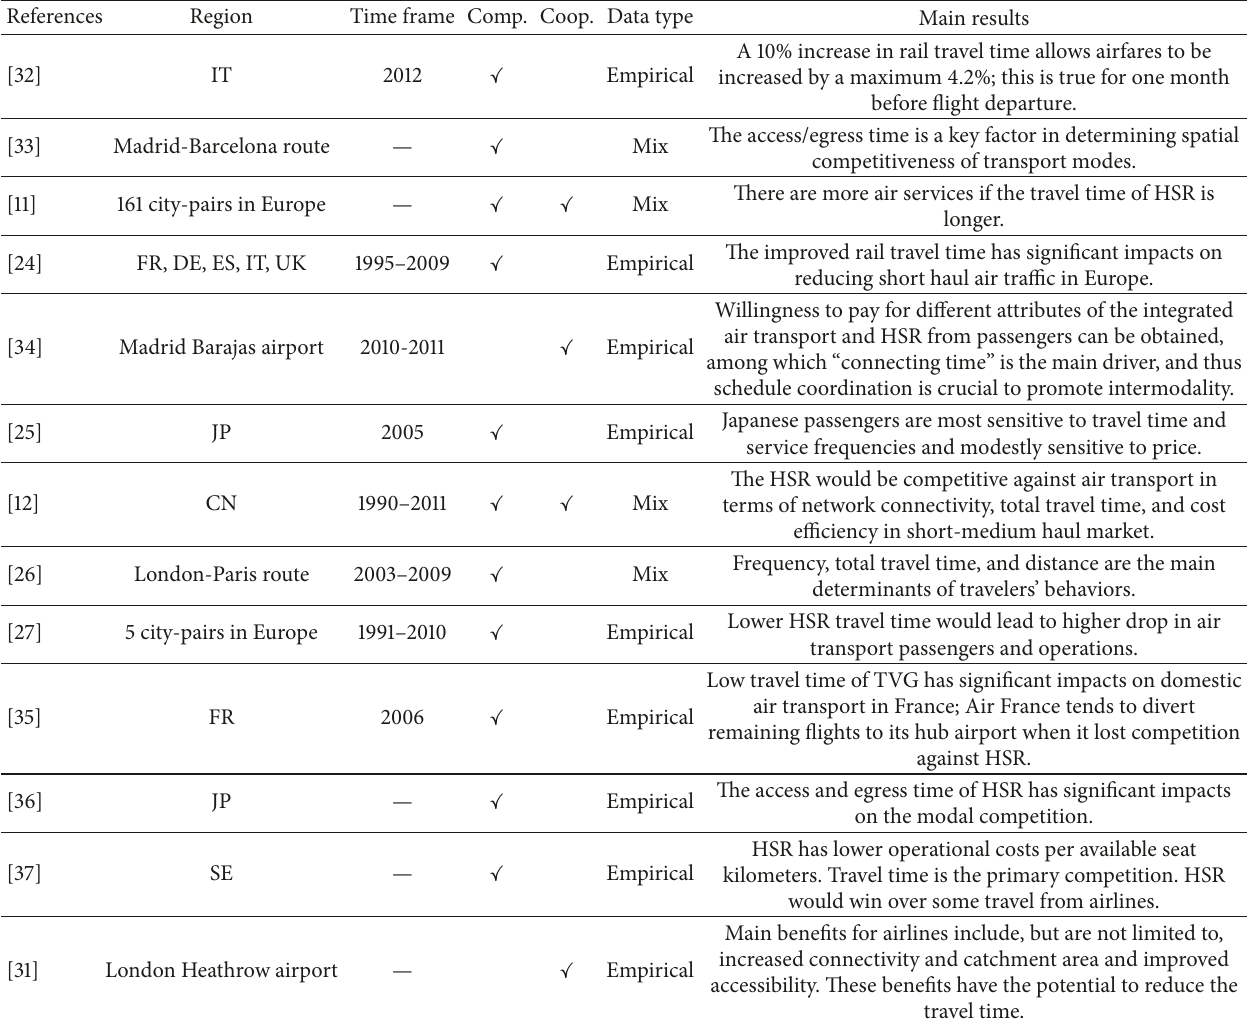
Table 6: The competition and cooperation effects between air transport and HSR on travel